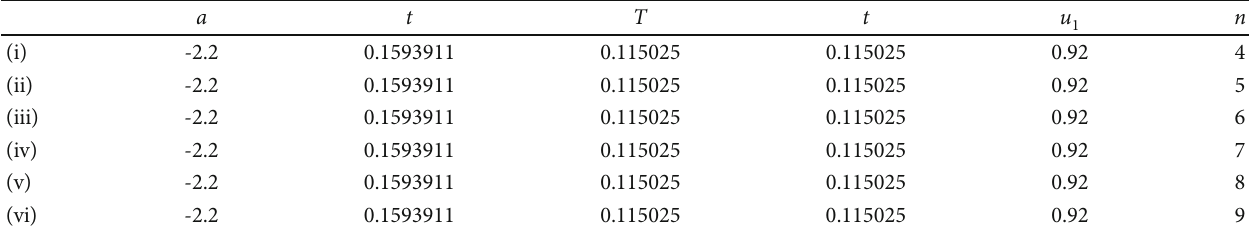
Table 7: Parameters for generation of Mandelbrot set for di ff erent values of n